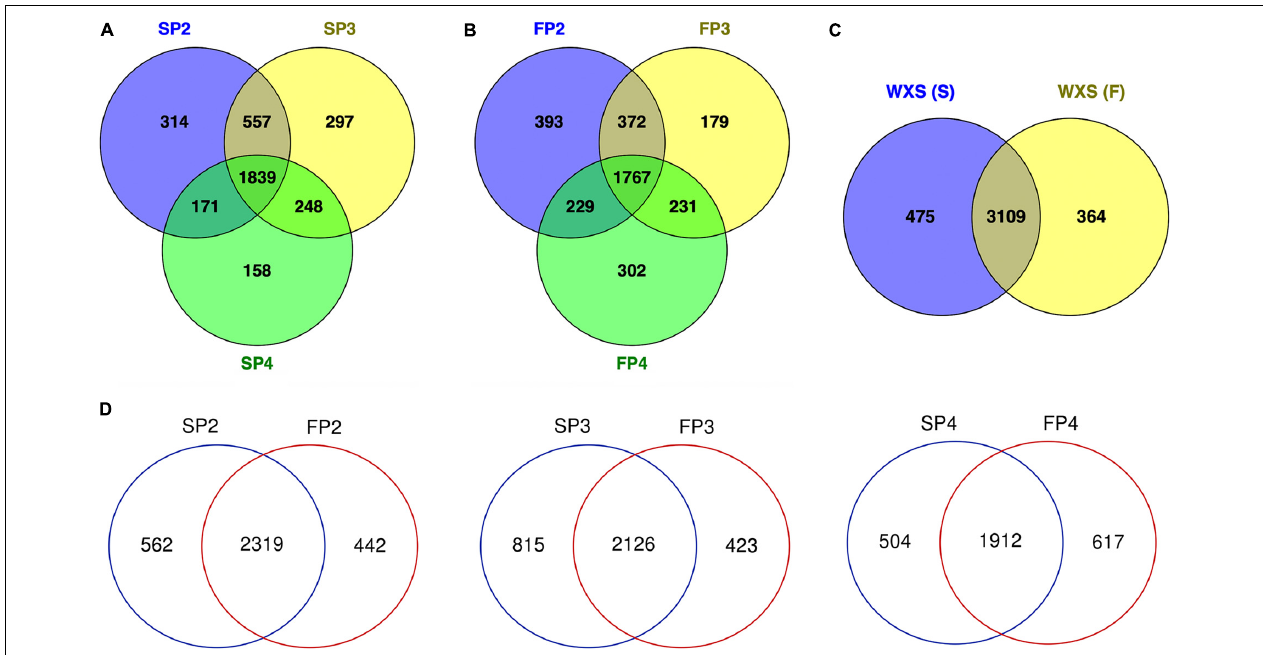
FIGURE 2 | Venn diagram detailing shared and distinct lncRNAs expressed in the PTGMS rice line WXS at three pollen developmental stages. (A) Venn diagram showing the number of lncRNAs expressed at three different developmental stages of the male sterile line WXS-S. (B) Venn diagram showing the number of lncRNAs expressed at three different developmental stages of the male fertile line WXS-F. (C) Venn diagram showing the total number of lncRNAs expressed in the sterile and fertile lines. (D) Venn diagram showing the number of lncRNAs expressed at the three different developmental stages in WXS-S and